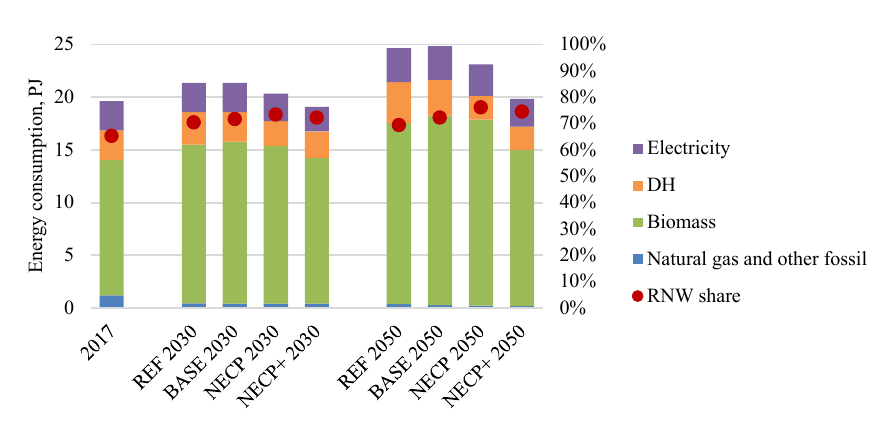
Fig. 8. Energy consumption in wood sub-sector in the modelled